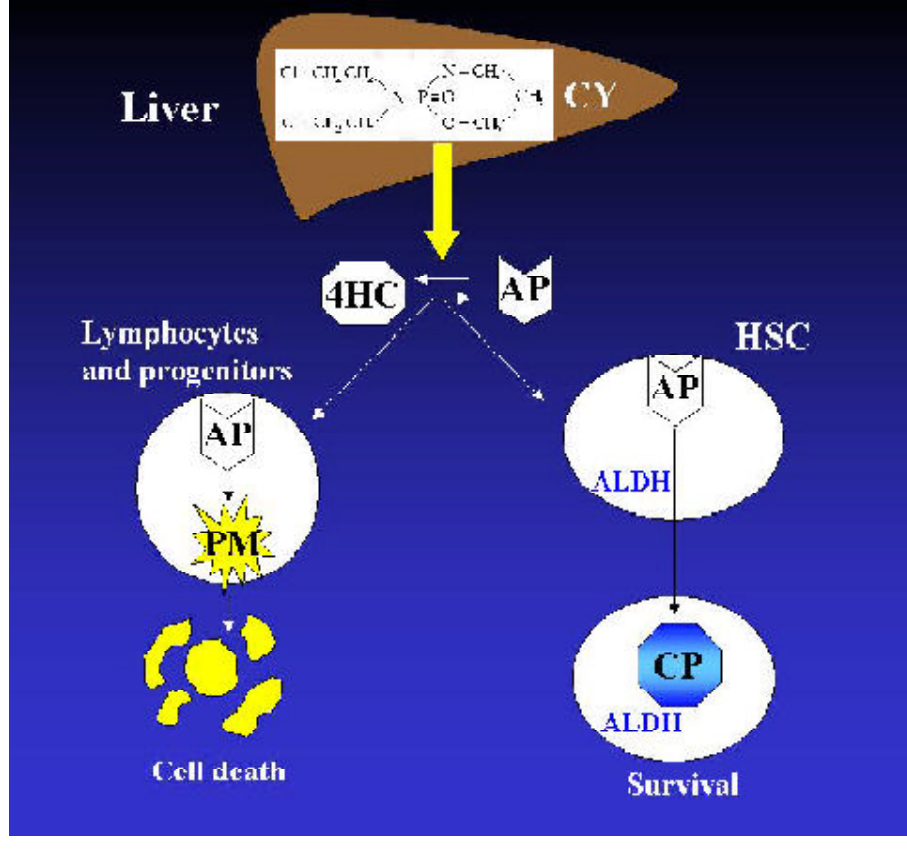
FIGURE 1. Pharmacology of high-dose cyclophosphamide. Cyclophosphamide (CY) is converted in the liver to 4 hydrodroxycyclophosphamide (4HC) and its tautomer aldophosphamide (AP), which diffuses into cells. Hematopoietic stem cells (HSC) have high-levels of aldehyde dehydrogenase (ALDH) which converts AP into the inert compound carboxyphosphamide (CP). Lymphocytes and progenitor cells have low levels of ALDH. In these cells AP is converted into the active compound phosphoramide mustard (PM) leading to cell